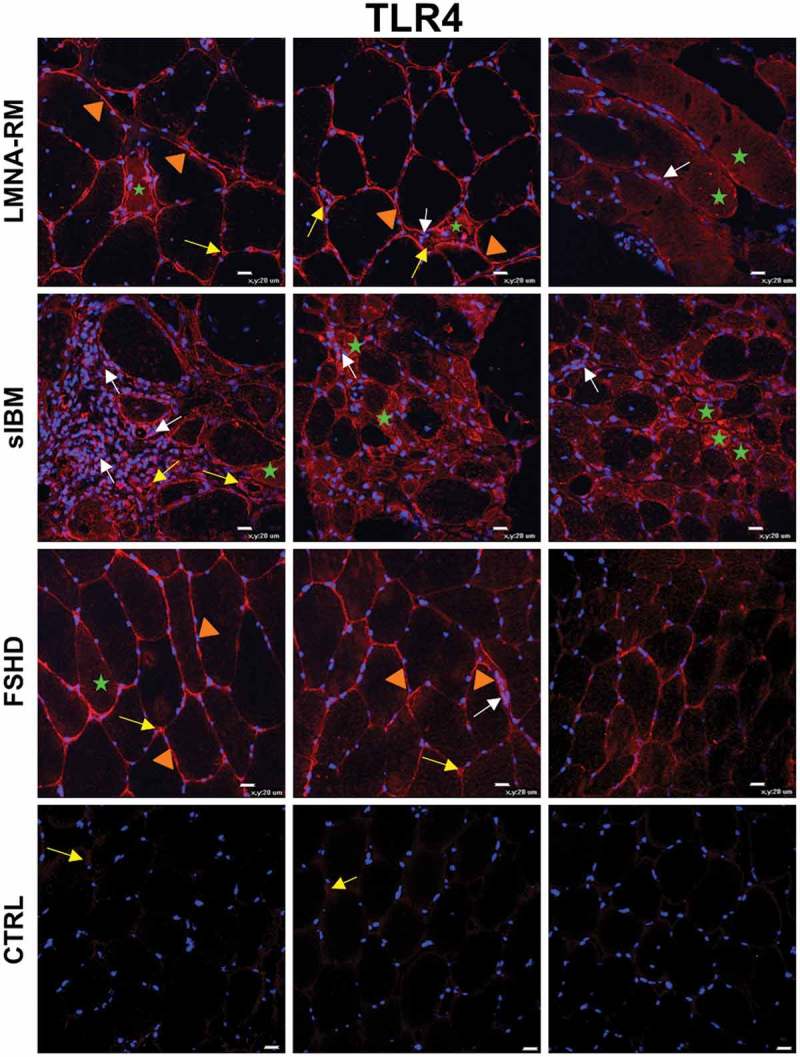
Immunofluorescence of TLR4 in LMNA-RM, sIBM, FSHD patients and non-myopathic control (CTRL) muscles. In LMNA-RM, sarcolemma (orange arrowheads), sporadically sarcoplasm (green stars) of some muscle fibers and capillaries (yellow arrows) were highly positive for TLR4. In sIBM, TLR4 was strongly expressed within small sized degenerated/regenerated myofibers (green stars), at the level of muscle infiltrating cells (white arrows) and on capillaries (yellow arrows). FSHD showed a TLR4 positive staining mainly on the sarcolemma of some muscle fibers (orange arrowheads), rarely in the sarcoplasm (green star) and on capillaries (yellow arrows), whereas in control muscle tissues a weak TLR4 immunopositivity was observed on capillaries (yellow arrows). Original magnification, X40; bar 20 μm.